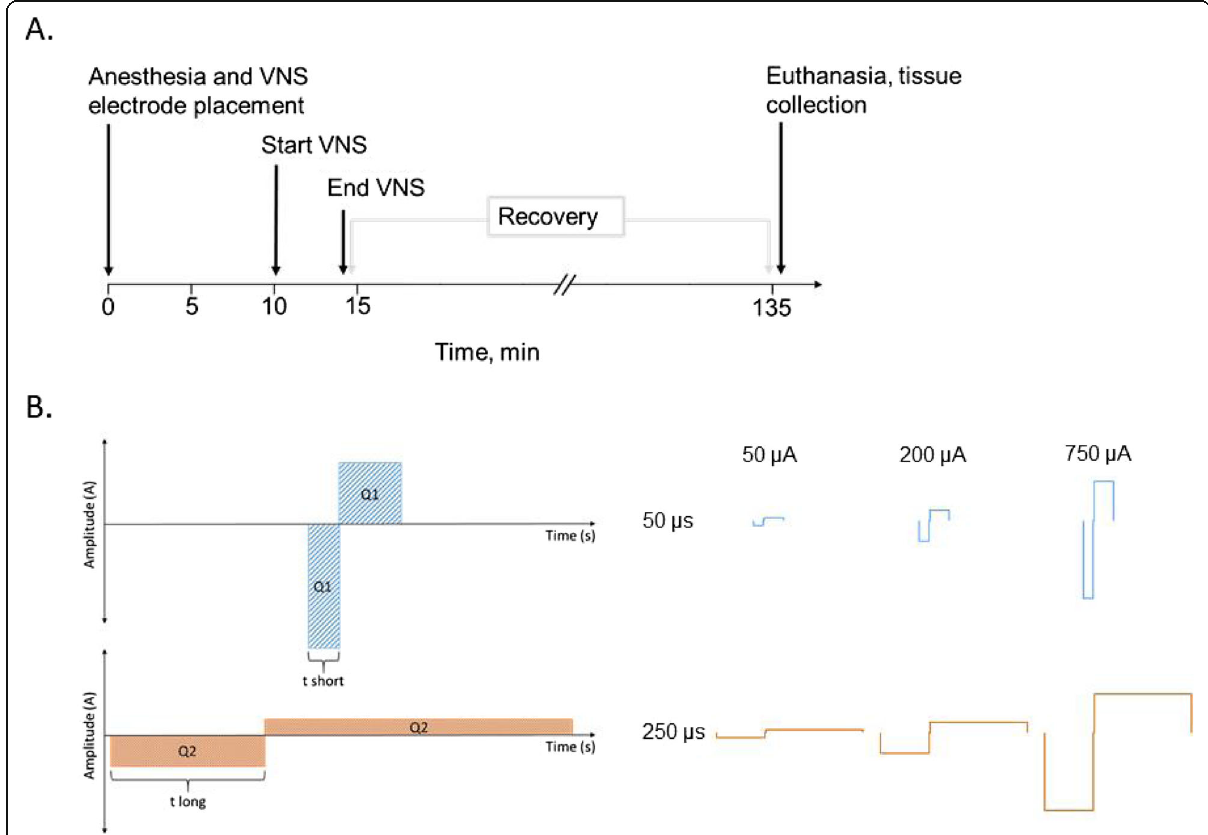
Fig. 1 Experimental design and stimulation pulse waveforms. a Experimental timeline. Electrical stimulation pulse trains were applied to the exposed left cervical vagus nerve for 4 min under anesthesia. Following stimulation, the animals were recovered for 2 h, euthanized, and whole blood was collected through cardiac puncture. b Schematic of the charge-balanced stimulation waveforms used during stimulation, with short pulse width (top) and long pulse width (bottom). The actual waveform shapes used in this study are shown to the